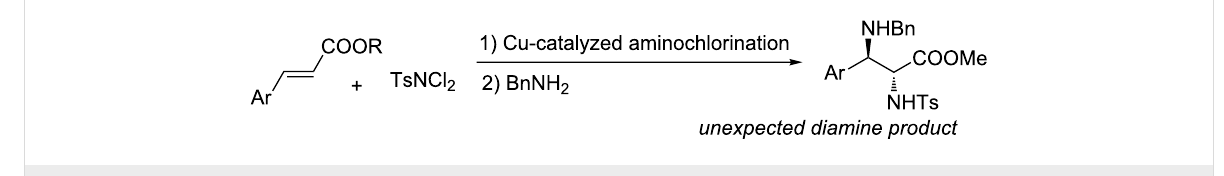
Scheme 1: An anomalous outcome with benzylamine as organic base.